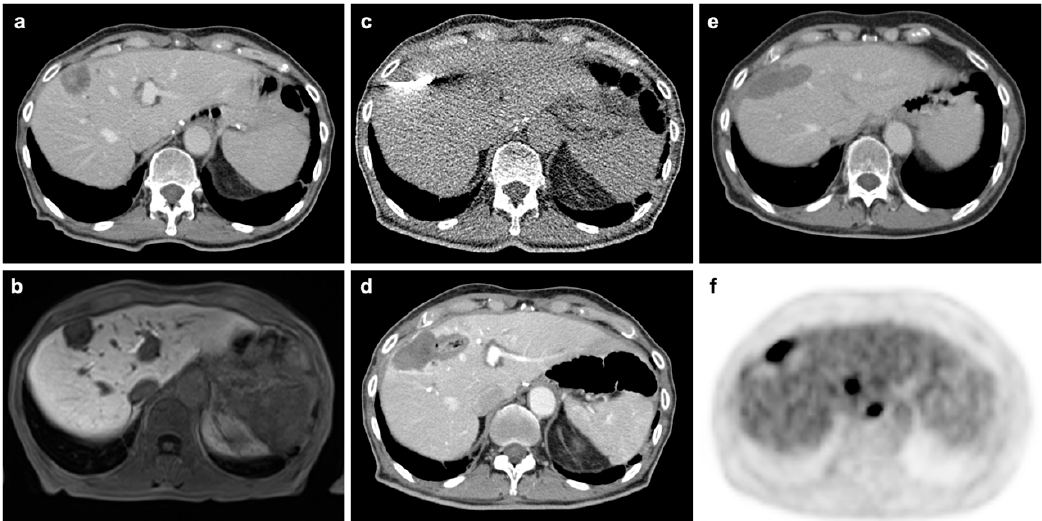
Figure 4. Patient from our institution undergoing microwave ablation (MWA) for oligometastatic liver disease. ( a ). Pre-interventional CT in portal-venous phase shows contrast-enhancing metastasis in segment VIII. ( b ). Pre-interventional MRI in hepatocyte-specific phase. ( c ). Interventional imaging during MWA. ( d ). CT in portal-venous phase acquired immediately after intervention without evidence of complication or residual tumor. ( e ). Four-month follow-up F-18 FDG PET / CT without morphological evidence of recurrence in CT component. ( f ). PET-component acquired at same scan 4-month after MWA with tracer accumulation at the margins of the previous ablation in line with recurrence. Additional metastases without morphological evidence in the CT component can also be depicted.